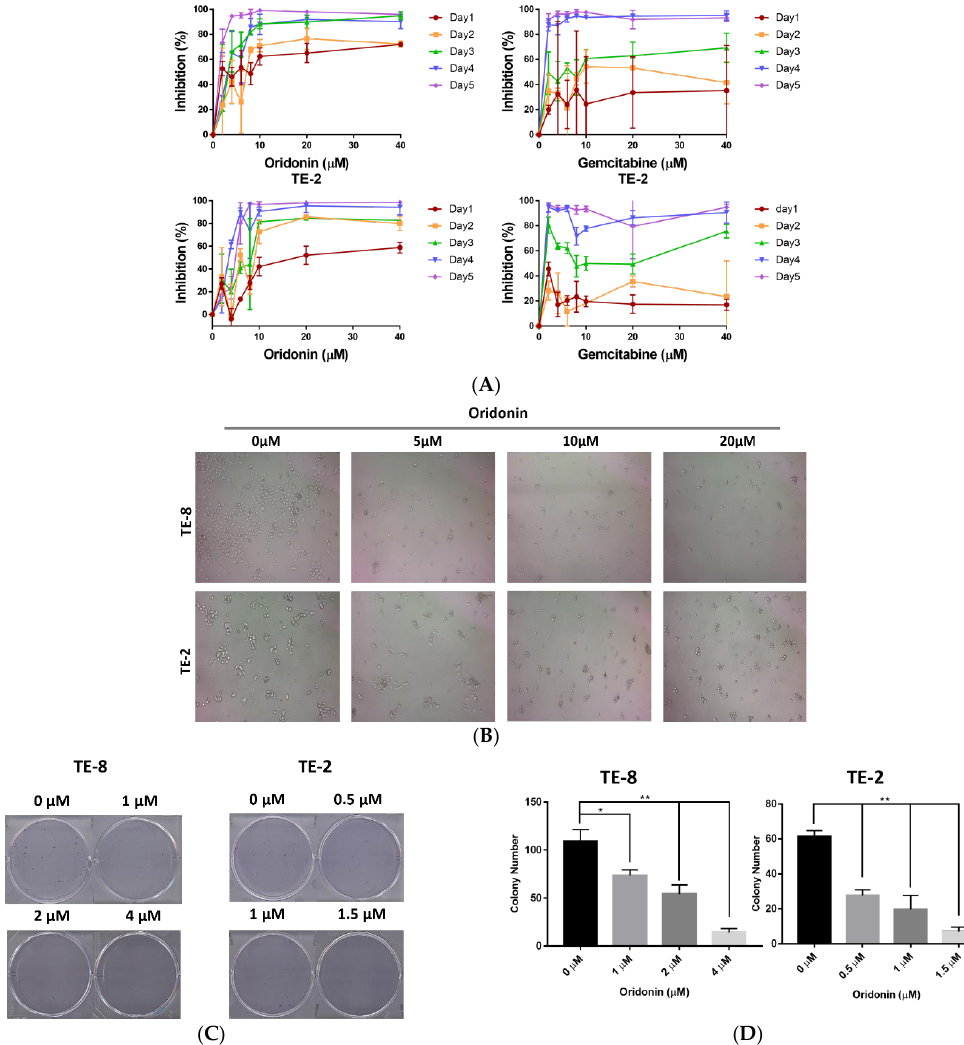
Figure 2. Oridonin has cytotoxicity on esophageal squamous cell carcinoma (ESCC) cells. ( A ) Oridonin inhibits the proliferation of ESCC cell lines. ESCC cells were treated with different concentrations of oridonin or Gemcitabine (positive control) for the indicated intervals. Proliferation was measured by sulforhodamine (B) (SRB) assay and inhibition% was calculated as described. IC 50 of oridonin treatment on TE-8 for 72 h is 3.00 ± 0.46 µ M, while of the positive control, Gemc- itabine treatment on TE-8 for 72 h is 5.71 ± 1.07 µ M. IC 50 of oridonin treatment on TE-2 for 72 h is 6.86 ± 0.83 µ M, while of Gemcitabine on TE-2 is 5.96 ± 1.11 µ M. ( B ) Observation of cellular morphol- ogy upon oridonin treatment at the indicated concentrations for 72 h. Cells shrunk and rounded with increasing concentration of oridonin. ( C , D ) Oridonin treatment suppressed colony formation of TE-8 and TE-2 cells in a dose-dependent manner compared to the controls (* p < 0.05, ** p < 0.01). The colony number represents the cell survival ability, while the colony size shows the cell proliferation ability. Data are expressed as mean ± SEM from three independent